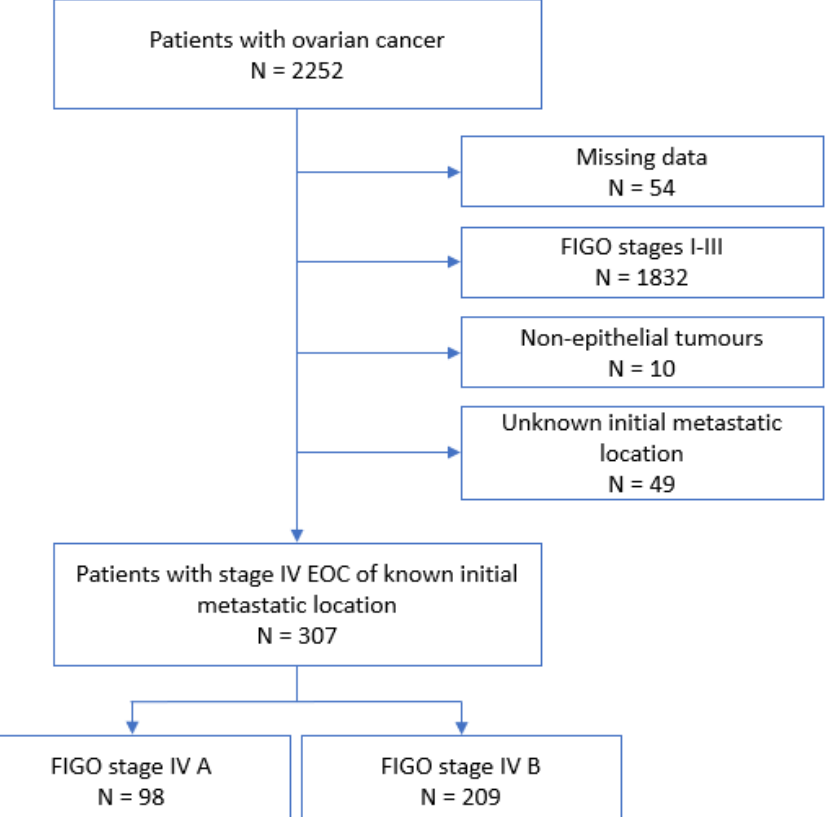
Figure 1. Flow chart. EOC: epithelial ovarian cancer.